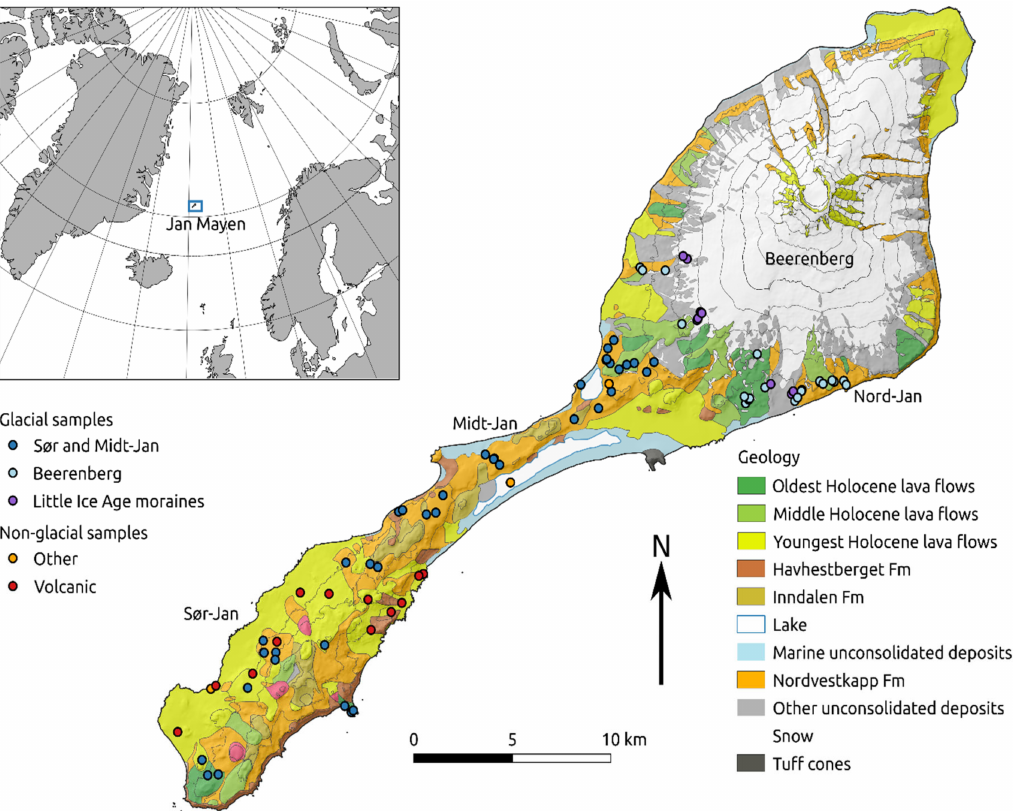
Figure 1. Geological map of Jan Mayen [3]. The different map unit colors indicate the different ages of the lava flows. Sample locations are marked by circles and the colors indicate the sample setting: dark blue indicates samples from glacial settings on south and central Jan Mayen; light blue indicates glacial samples from the slopes of Beerenberg; purple indicates samples from the young Little Ice Age (LIA) moraines; red indicates samples that are related to volcanism; samples that are unrelated to deglaciation or volcanism are classified as “other” and indicated in